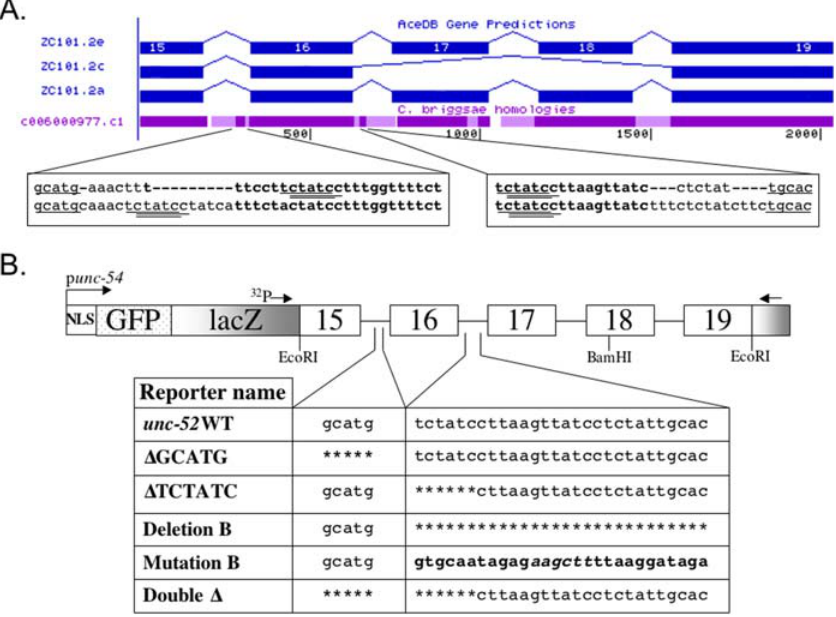
Figure 3. Conserved Intronic Elements of unc-52 Contain Putative Regulators of Alternative Splicing (A) C. elegans and C. briggsae sequence alignment is shown for the alternatively spliced portion of unc-52 . Not all spliced isoforms are predicted by Wormbase software (blue); see Figure 4A for observed alternative splicing patterns . PhastCons sequence alignment is shown with WABA-designated conservation in bold. Upper line of sequence is C. elegans; C. briggsae is below. High-scoring conserved motifs identified in our pentamer/hexamer analysis of conserved intronic elements flanking alternatively spliced exons, GCATG, TCTATC, CTATCC, CTATC, and TGCAC are underlined. (B) Diagram of alternative splicing reporter constructs for testing putative cis -regulatory splicing motifs. Part of exon 15 through part of exon 19 of unc- 52 was cloned into a GFP/lacZ fusion vector with an unc-54 promoter and nuclear localization sequence suitable for expression in C. elegans. Site- directed mutagenesis of the wild-type substrate was performed in order to test putative cis -splicing regulatory elements . A table of the splicing reporter constructs and their alterations is shown. Asterisks denote highly conserved intronic nucleotides deleted by site-directed mutagenesis. To maintain the intron length, yet remove motifs in question, a reporter was also made in which native sequence was replaced with the reverse complement sequence (shown in bold) and a HindIII site (italics) for diagnostic